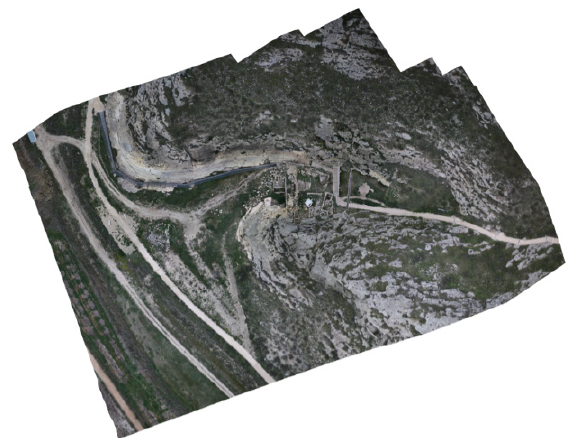
Figure 9. Orthoimages of the whole settlement (up) and defensive area “El Reguerón” (down).